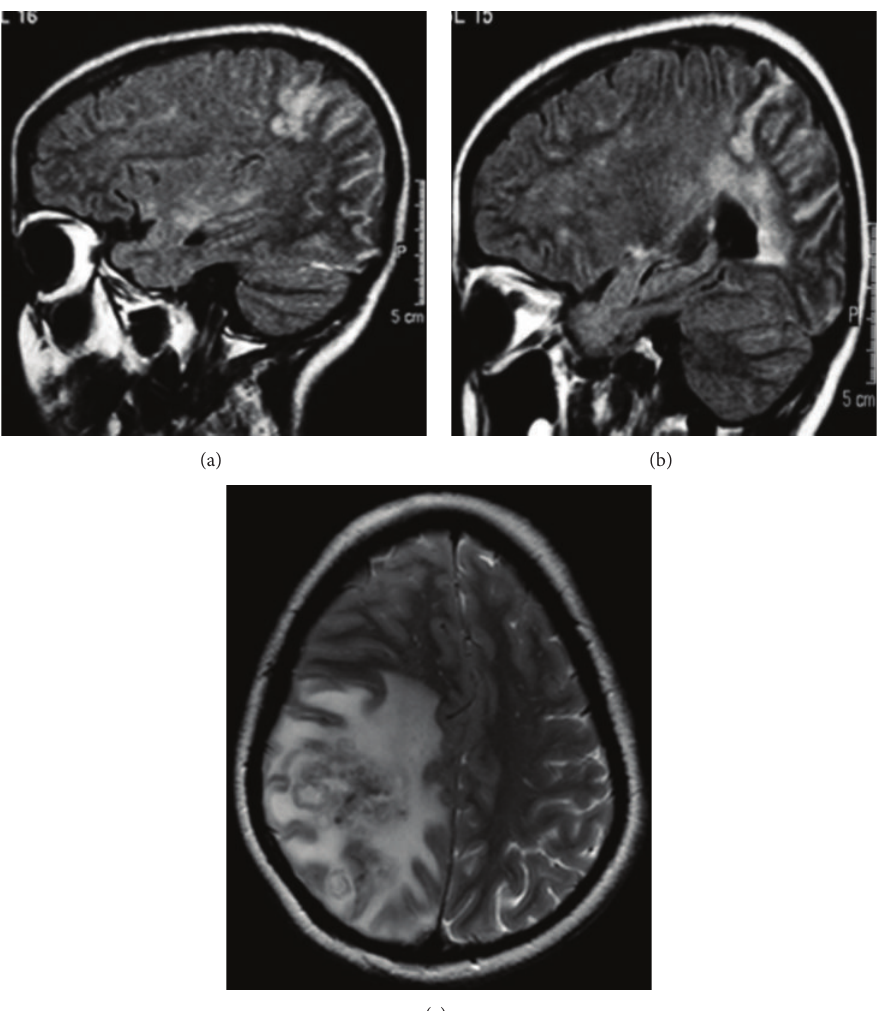
Figure 1: (a) MRI brain 5 days into admission in August 2005 showing right-sided occipitoparietal leptomeningeal inflammation. (b) MRI brain on readmission December 2005, 4 months after initial presentation showing worsening right-sided occipitoparietal leptomeningeal inflammation. (c) T2-weighted MRI brain in December 2006, 16 months after initial presentation showing large clusters of ring-enhancing lesions and leptomeningeal inflammation in the right occipitoparietal area with oedema and midline shift. Also seen but not shown on this cross-section were smaller clustered ring-enhancing lesions in the right thalamus and left frontal and temporal